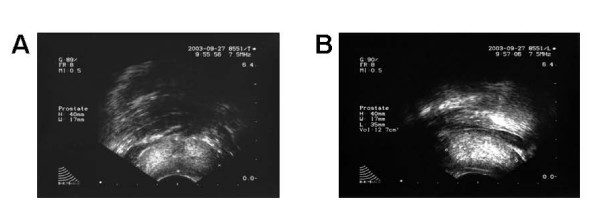
Diffusion of hyperechoic BTX-A over the canine prostate immediate after BTX-A injection. A. Transverse view. B. Longitudinal view.